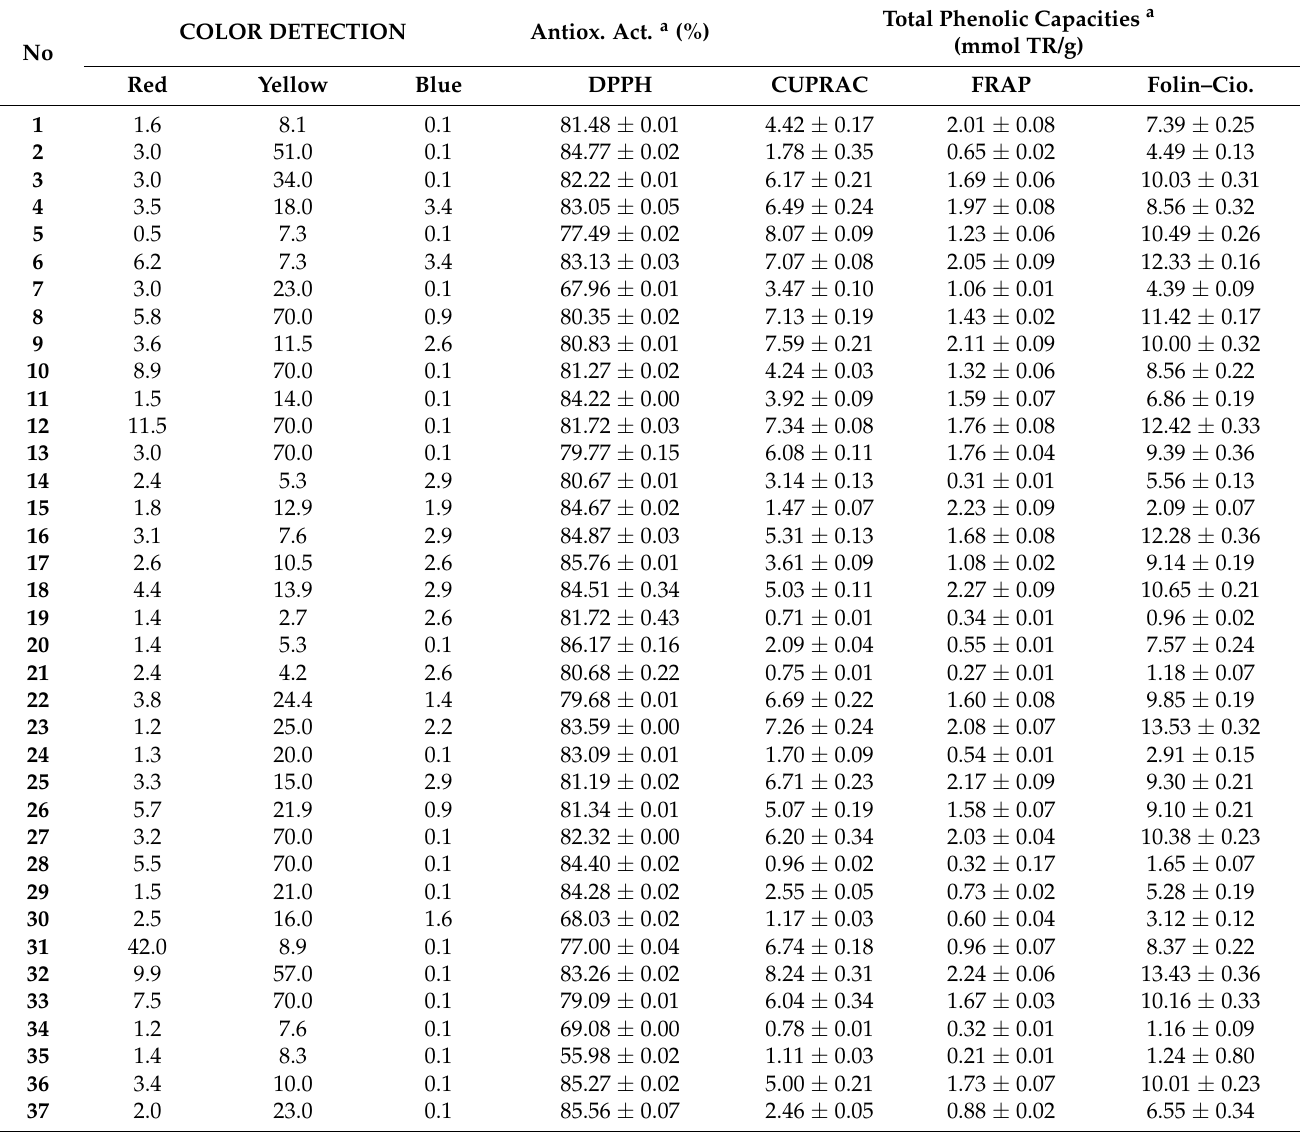
Table 1. Antioxidant capacity, total phenolic contents and color index of propolis samples collected from